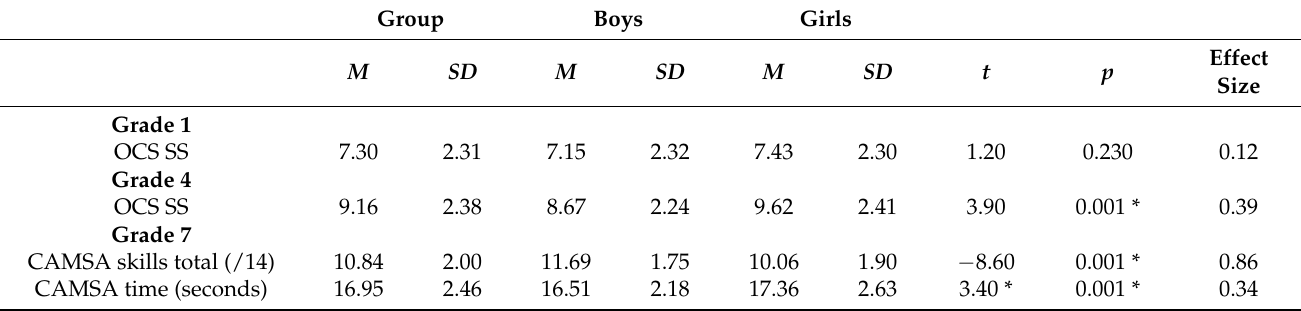
Table 2. Descriptive results of OCS SS (Grade 1, 4, and 7) and CAMSA (total score and time in Grade 7) by group and for boys and girls